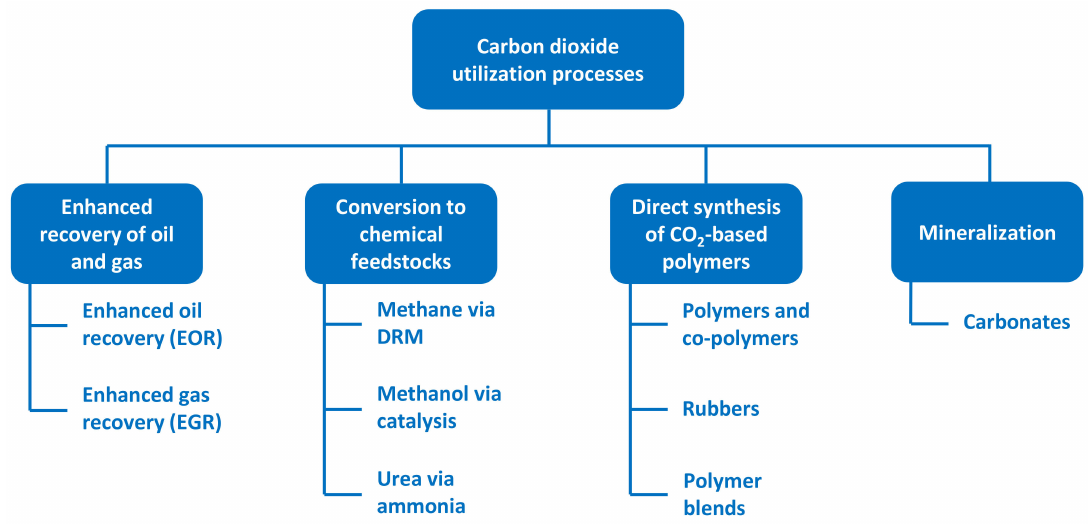
Figure 6. Carbon dioxide utilization processes, adapted from Al-Mamoori et al.